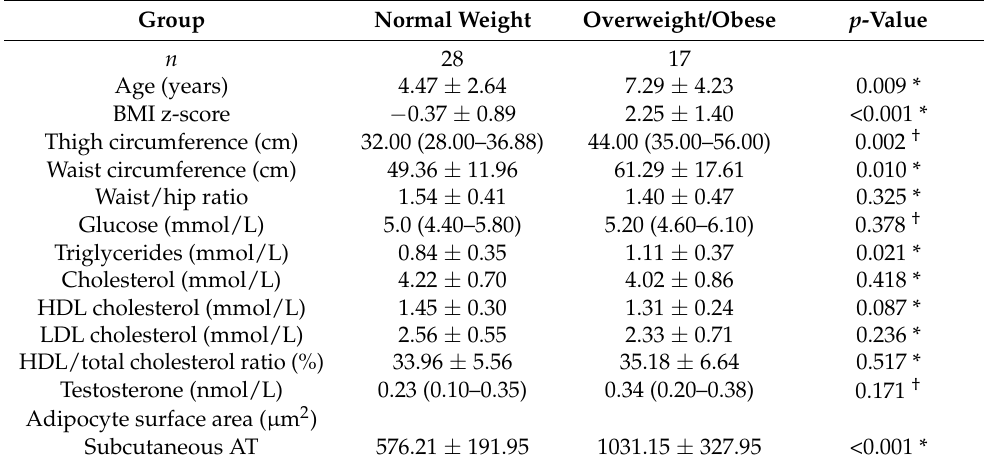
Table 1. Patients’